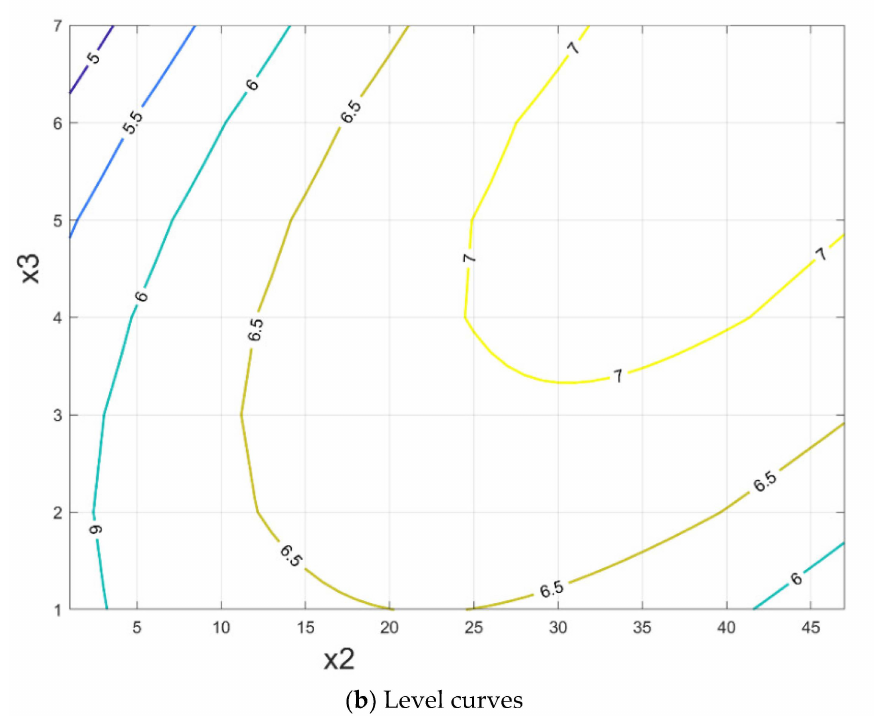
Figure 13. The briquettes resistance to cracking depending on the proportion of sludge mill scale and sintering sludge, for a medium value of ferrous sludge y 1 = f (x 1med, x 2 , x 3 ).